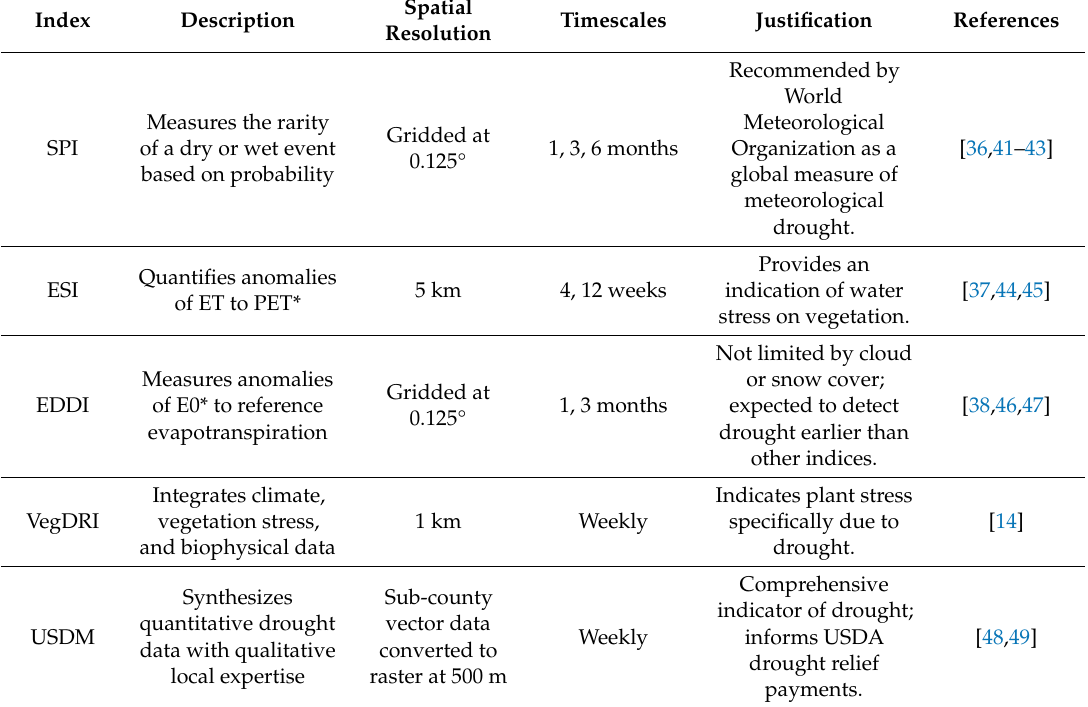
Table 1. Drought indices and tools used in the correlation analysis and in the predictive model. This table provides a simple description of each index, its spatial resolution and timescales used in our analysis, and a justification of why this index was selected for the